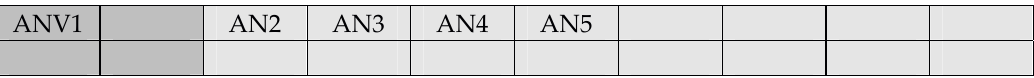
Figure 7. Proportions of the types of nozzles used.